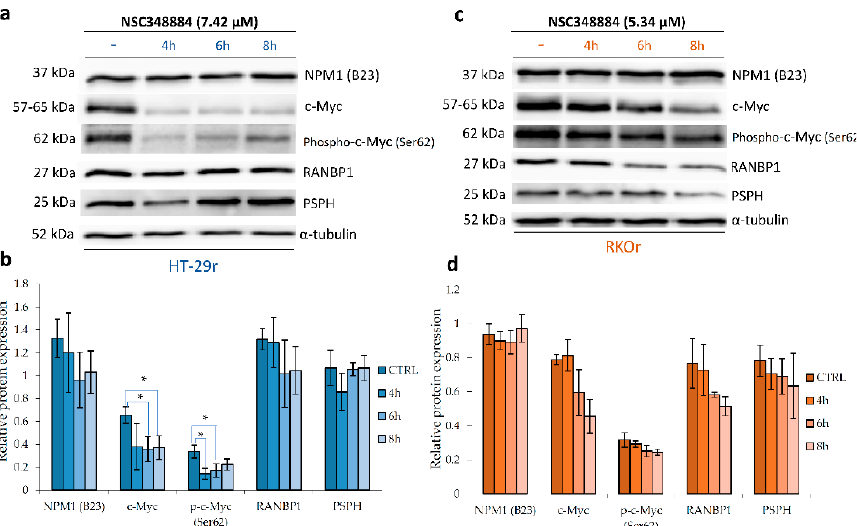
Figure 7. Western blot analysis of relative protein expression of nucleophosmin, c-Myc and its transcriptional targets RanBP1 and phosphoserine phosphatase (PSPH) in vemurafenib-resistant HT-29r ( a , b ) and RKOr ( c , d ) colon cancer cells with BRAFV600E mutation after the treatment with cytotoxic concentrations of nucleophosmin inhibitor NSC348884 for indicated time periods. Densitometry analysis of western blot bands was carried out by Quantity One software to calculate relative protein abundance ( b , d ). Data represent mean and standard deviation obtained from two independent biological experiments with two technical replicates. α - Tubulin was used as loading control. Statistical significance where p < 0.05 is denoted with an asterisk.